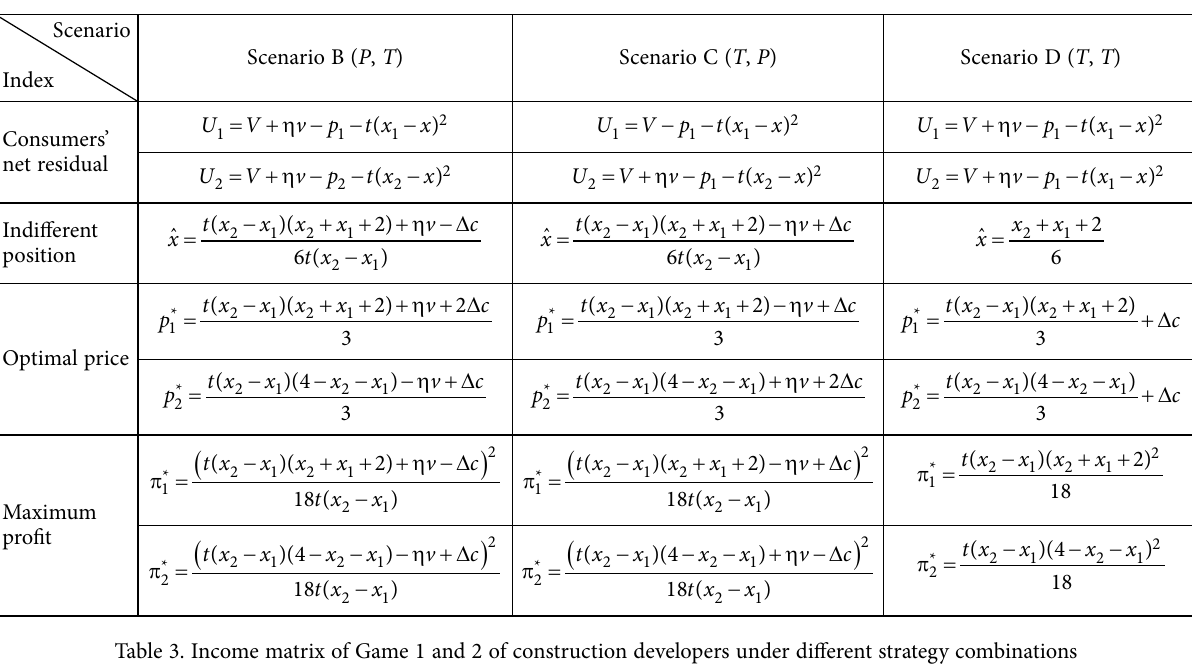
Table 2. Consumers’ net residual, indifferent position, optimal price, and maximum profit of construction